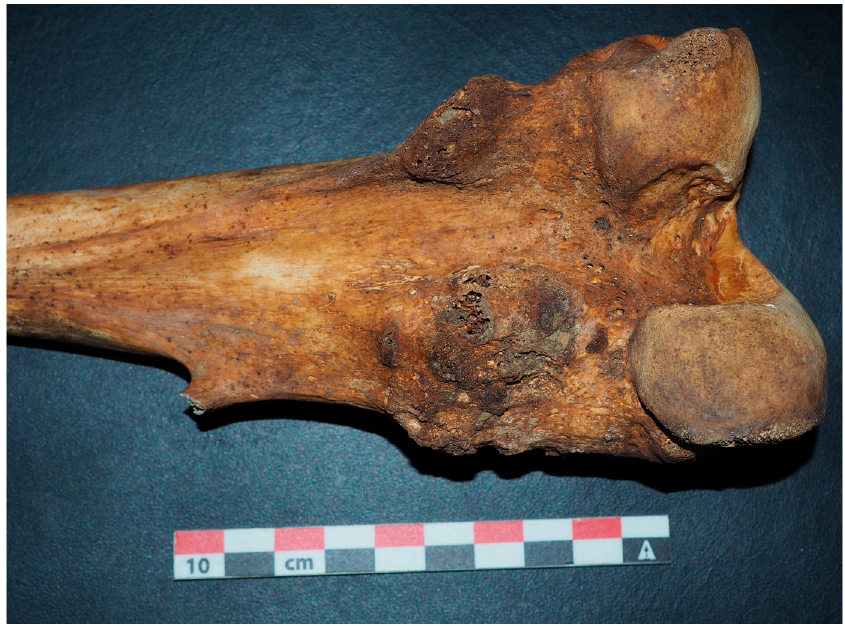
Figure 6. Distal femoral extremity with multiple osteochondromas, on a German soldier. © Marine Distal femoral extremity with multiple osteochondromas, on a German soldier. Meucci. © Marine